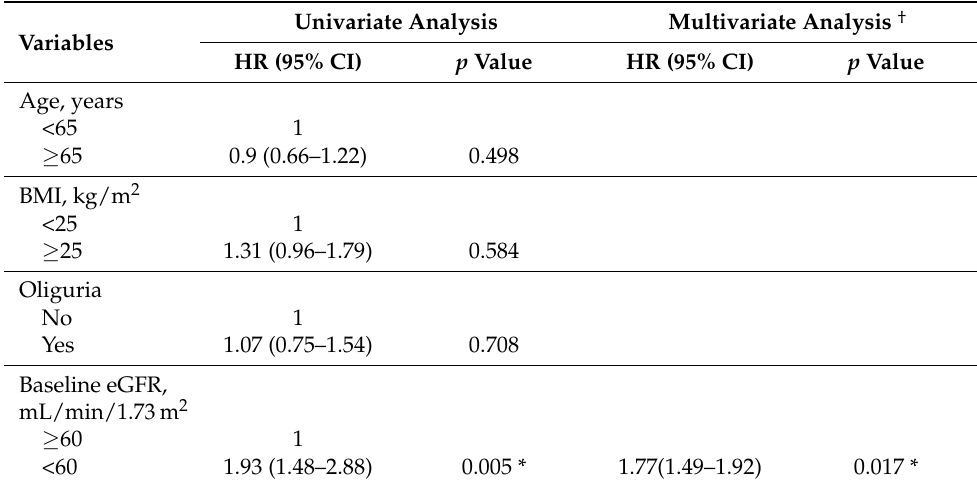
Figure 2. Forest plot of differences in the odds ratio estimates for mortality that are based on standard and high UFRs in the overall cohort and the pre-specified subgroups. Overall and in both subgroups, the risks for in-hospital mortality among patients with sepsis-induced MODS with standard versus high UFR were comparable. The black boxes represent the odds ratios, and the horizontal lines indicate the 95% confidence intervals. The vertical dashed line represents an odds ratio of 1.0. The diamond represents the pooled odds ratio, and its lateral tips represent the confidence intervals. Abbreviations: UFR, ultrafiltration rate; eGFR, estimated glomerular filtration rate; CVVH, continuous venovenous hemofiltration; APACHE, Acute Physiology and Chronic Health Evaluation; SOFA, sequential organ failure assessment. Table 3. Univariate and multivariate Cox regression analysis of variables associated with in- hospital